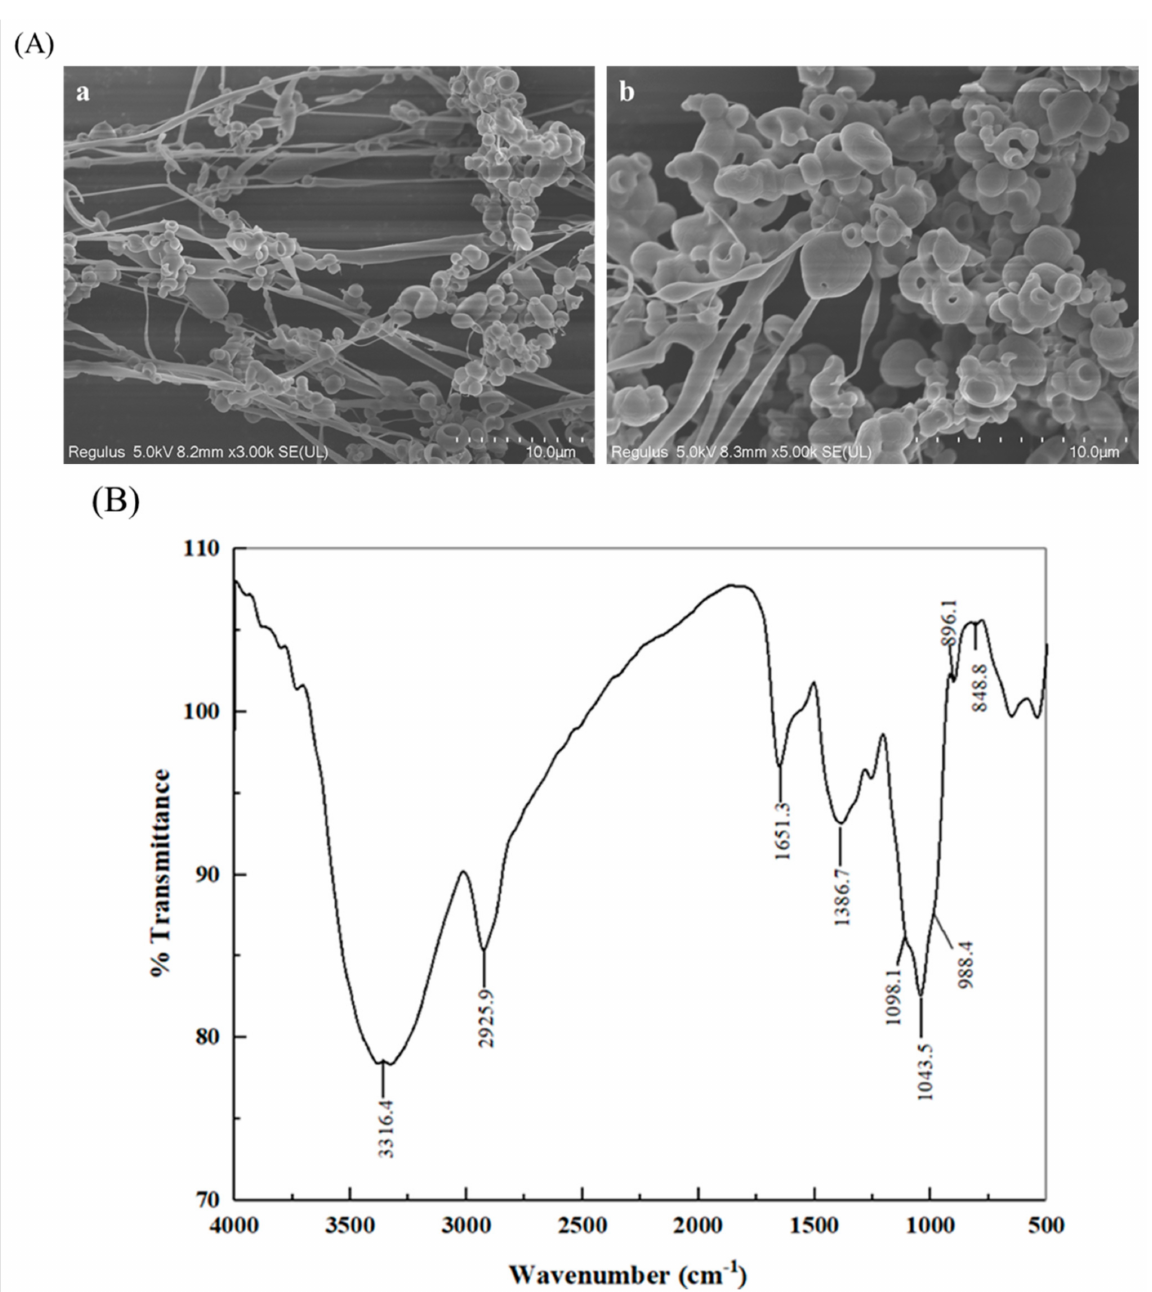
Figure 1. The results of SEM imaging and FT-IR spectroscopy: ( A ) SEM images at magnifications of ( a ) 3000 × and ( b ) 5000 × ; ( B ) FT-IR spectrum of